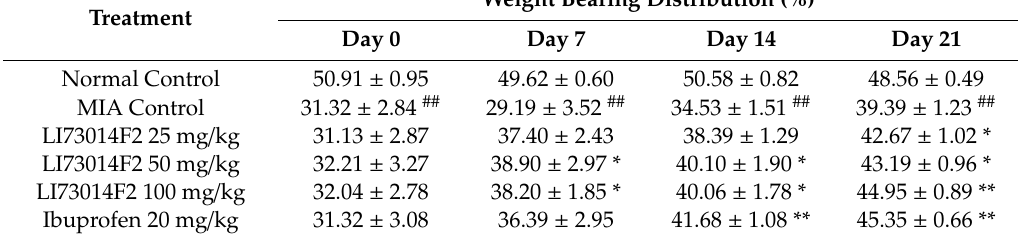
Table 1. Effects of LI73014F2 on the hind paw weight-bearing distribution for 21 days in MIA-induced osteoarthritis in rats. The data are presented as mean ± SEM ( n = 8/group). * p < 0.05, ** p < 0.01, compared to the MIA-induced control group; ## p < 0.01, compared to the non-MIA-induced control group.